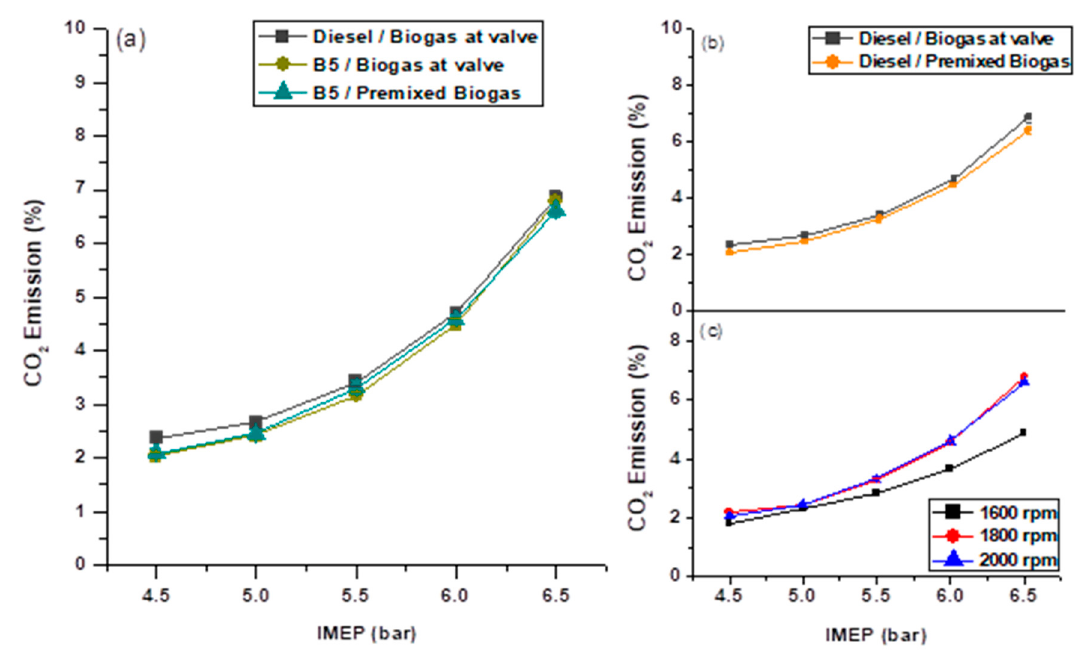
Figure 15. Engine-out CO 2 emission for ( a ) B5 / biogas RCCI for premixed and port injection at the valve, ( b ) diesel / biogas in a premixed and port injection at the valve, and ( c ) B5 and premixed biogas RCCI combustion at various engine speeds.